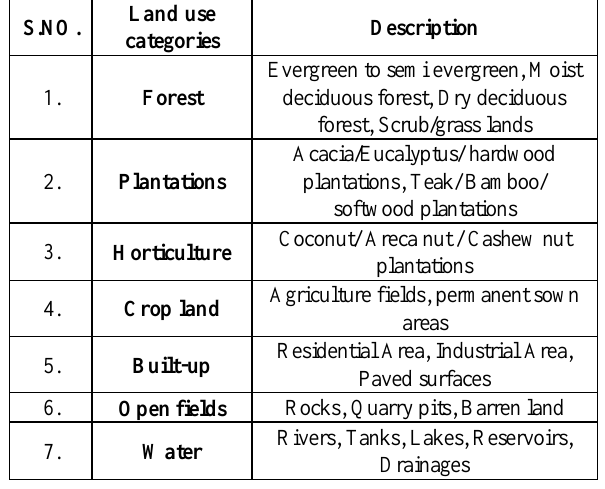
Table 1. Land use categories of Karwar